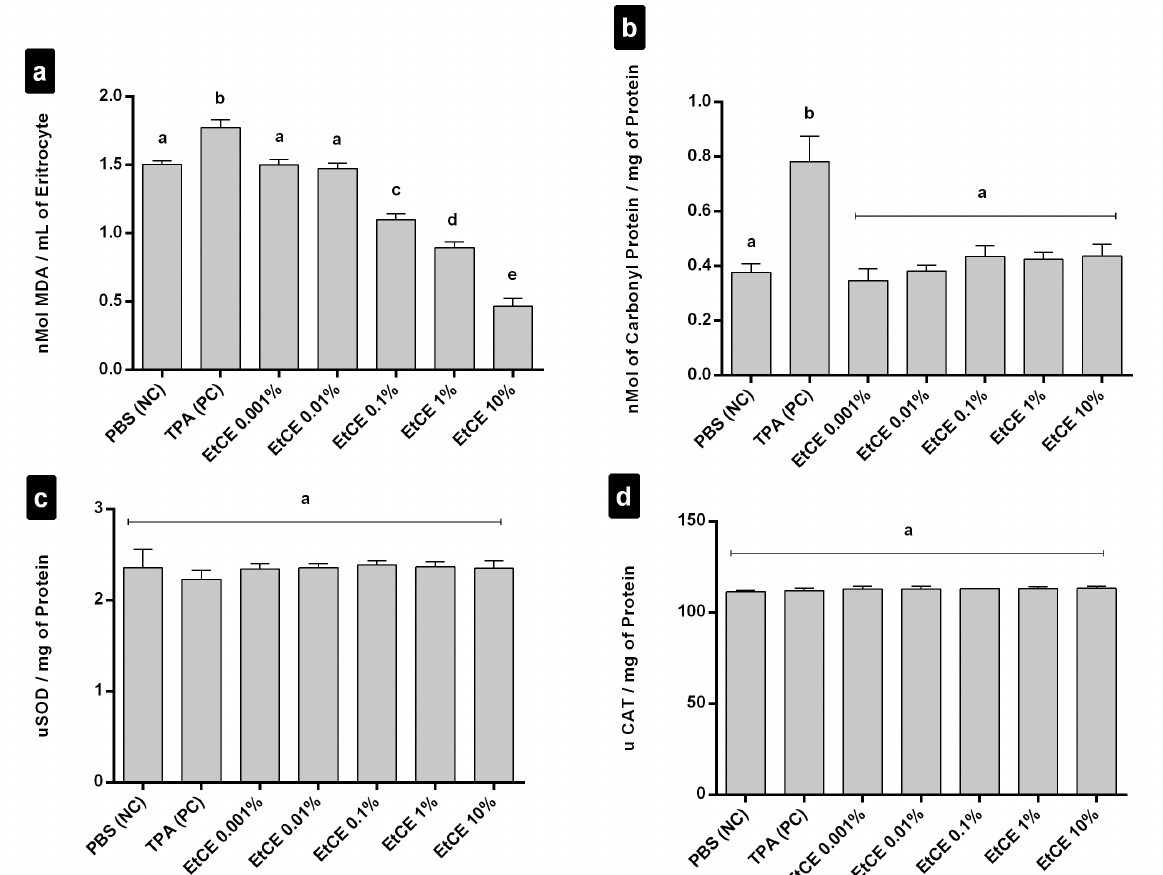
Figure 2 - Markers of oxidative effects. (a) lipid peroxidation, (b) carbonyl protein contents, (c) superoxide dismutase activity, (d) catalase activity. PBS: phosphate-buffered saline, TPA: 12-O-tetradecanoylphorbol-13-acetate, EtCE: Euphorbia tirucalli crude extract. Data are presented as mean ± SD (n = 3). Letters indicate statistically signi fi cant